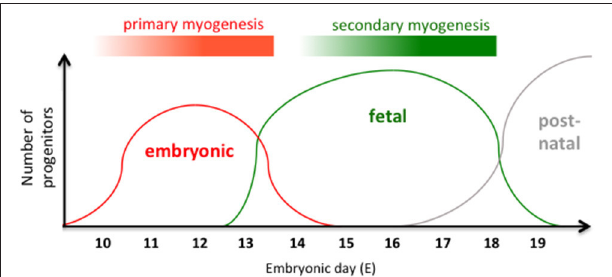
FIGURE 1 | Intrinsically different myogenic lineages govern embryonic and fetal phases of muscle fiber formation. Schematic representation of the major phases of myogenesis that are occurring during skeletal muscle development. Embryonic progenitors that are responsible for primary myogenesis are predominating between E10 and E13, whereas fetal progenitors that are responsible for the secondary myogenesis are predominating between E14 and E18. Post-natal progenitors/stem cells are responsible for muscle growth after birth. The developmental time corresponding to the different phases of myogenesis in the mouse is indicated on the x-axis. Embryonic days are counted, considering E0.5 the morning of the vaginal plug. Myotomal cells giving rise to the early embryonic myotome is omitted from this